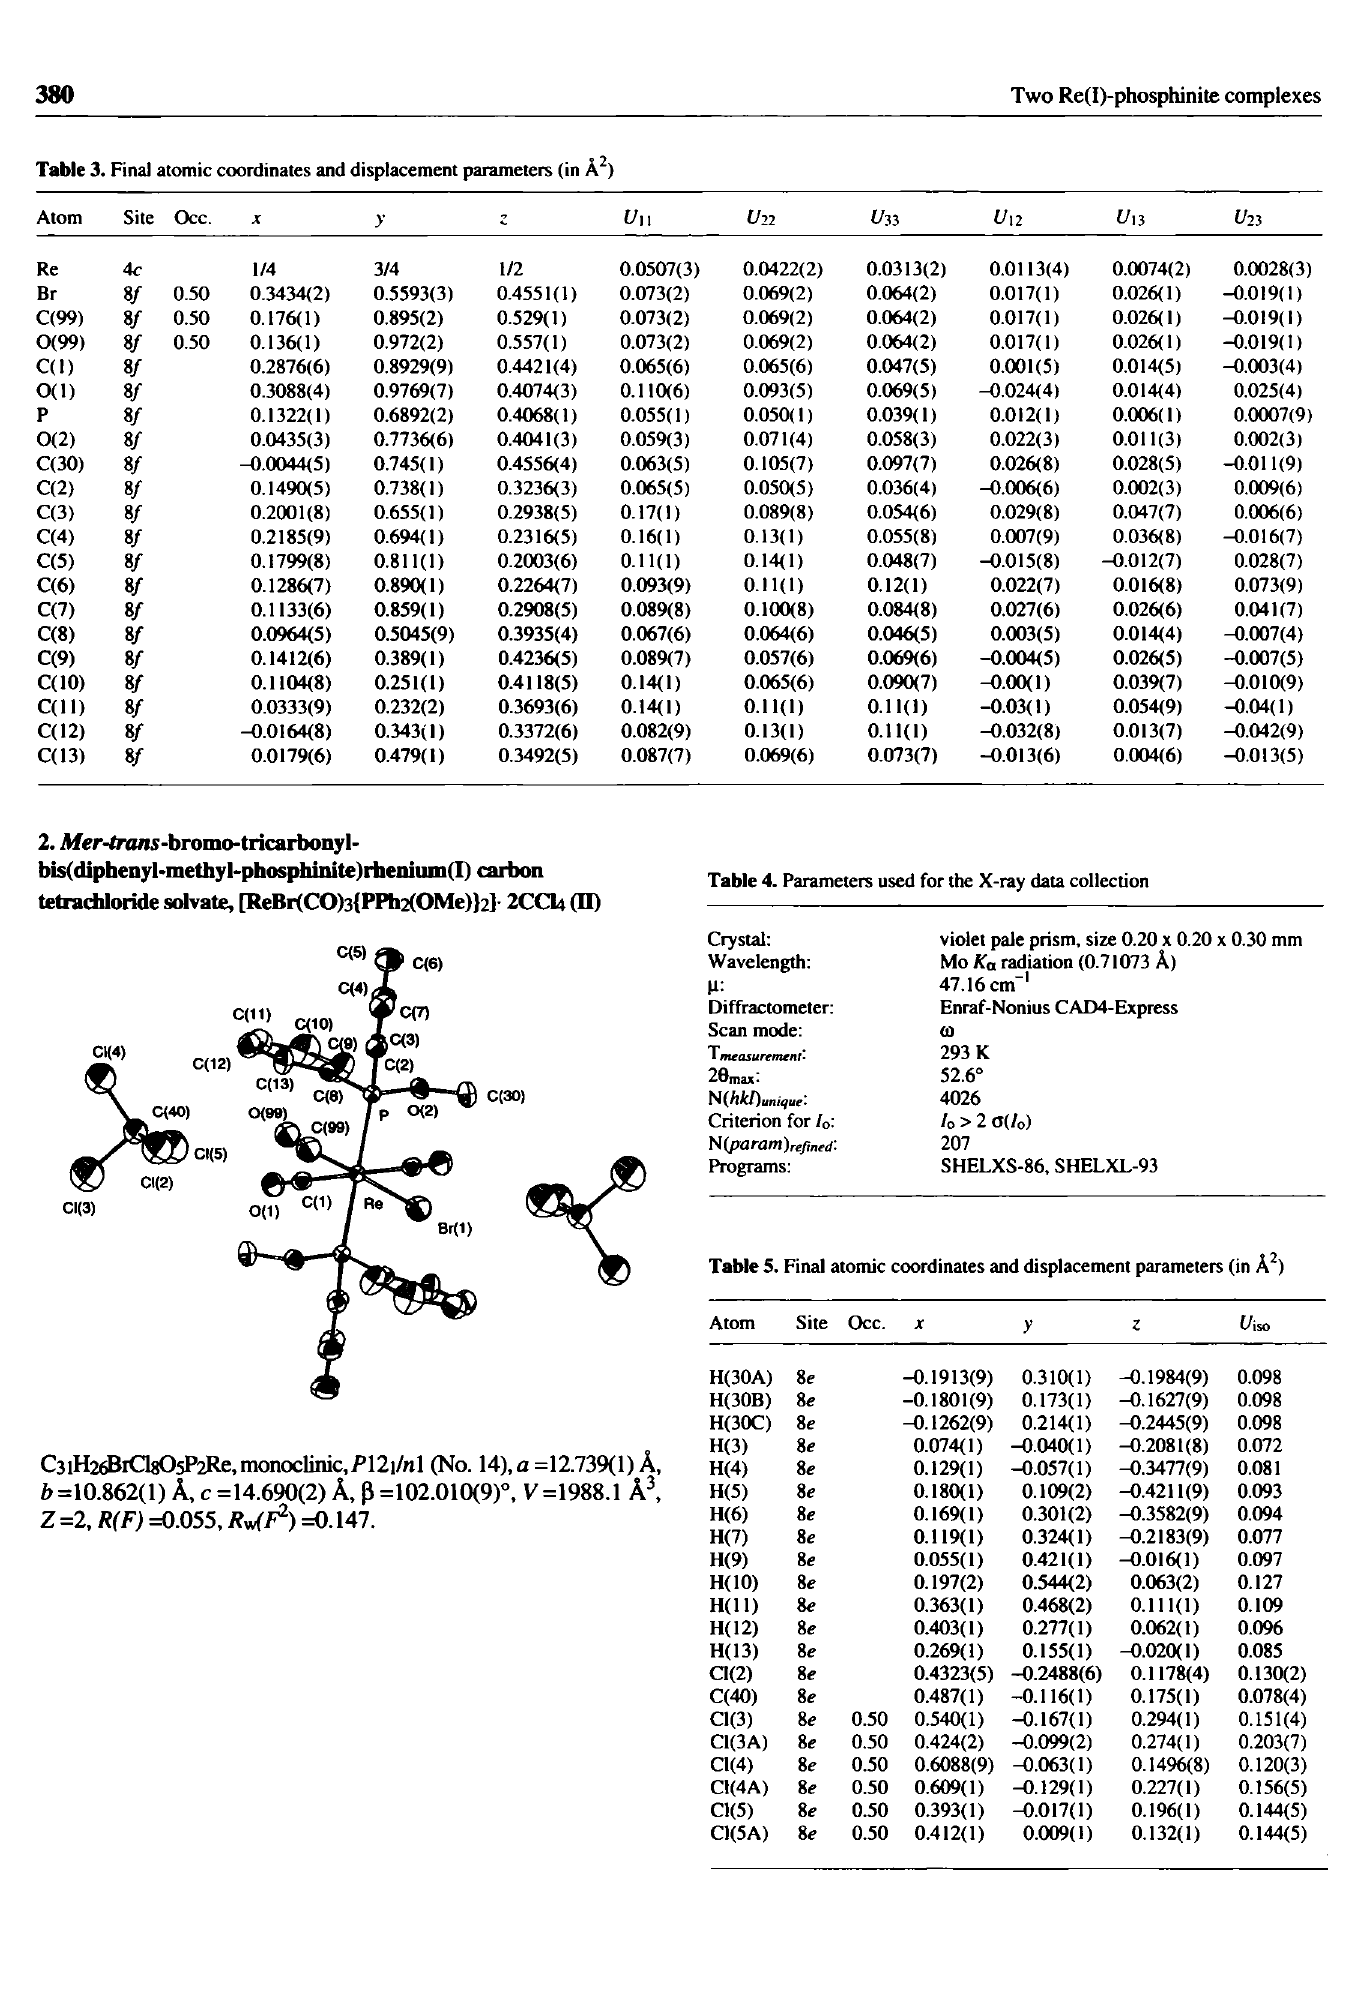
Table 3. Final atomic coordinates and displacement parameters (in Â^) Atom